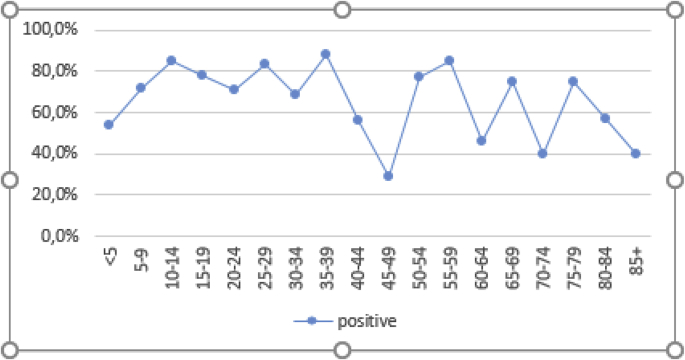
H. pylori by age.